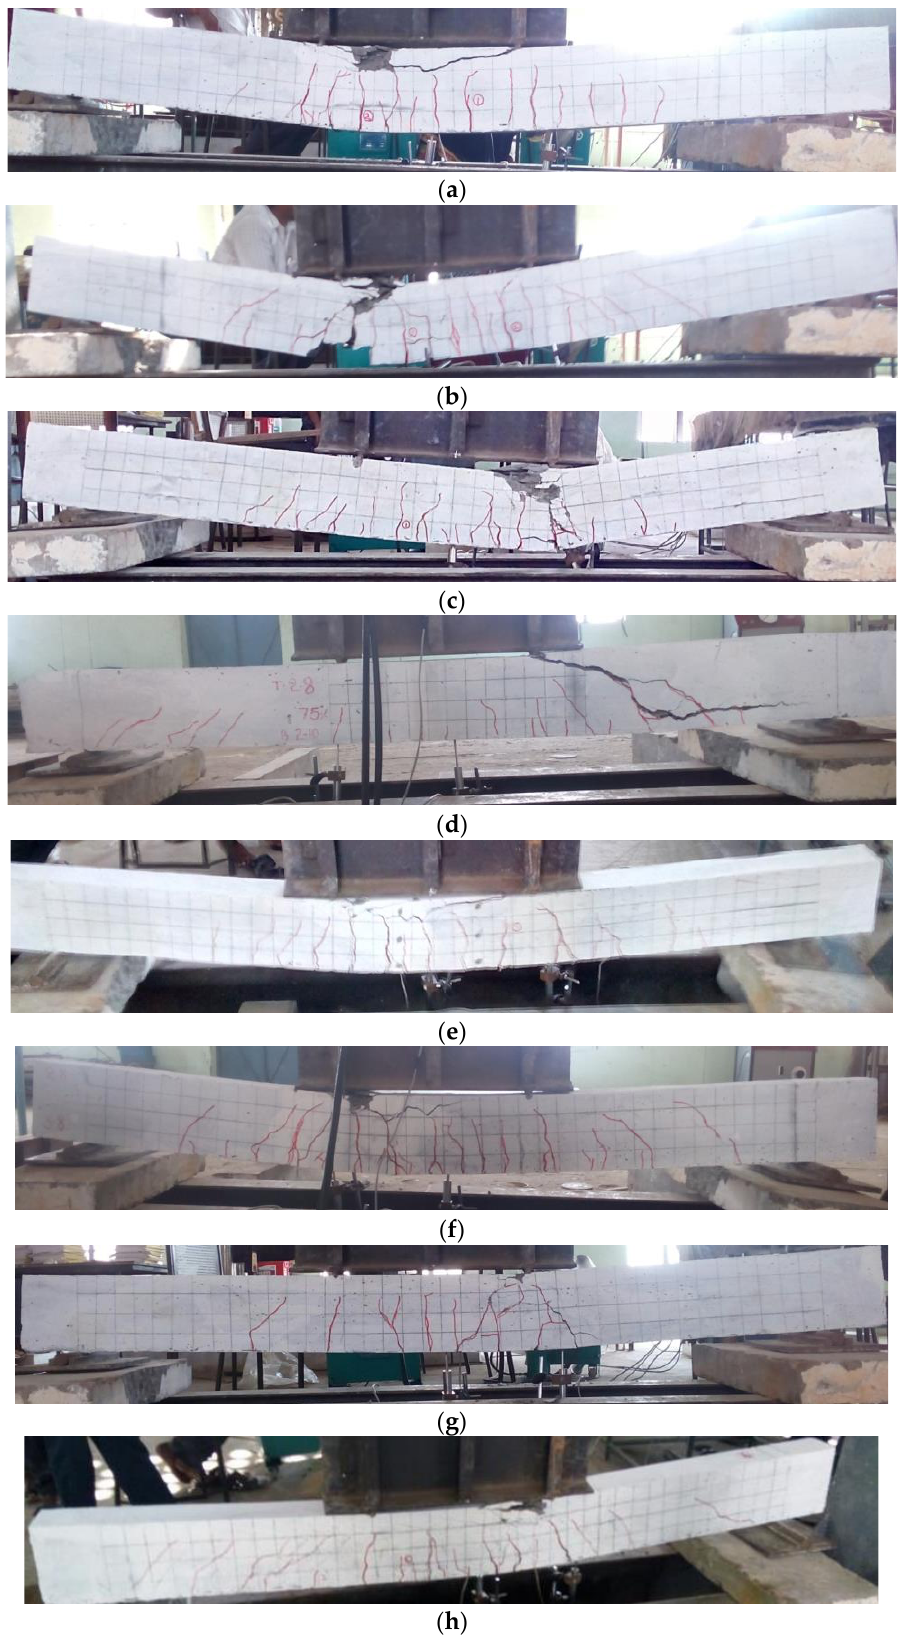
Figure 8. Failure pattern of sandwich beams ( a ) B1-1.0A; ( b ) B1-0.25A; ( c ) B1-0.5A; ( d ) B1-0.75A; ( e ) B2-0.5A-0.6; ( f ) B2-0.5A-0.9; ( g ) B2-0.5A-1.2; ( h ) B2-0.5A-1.5.